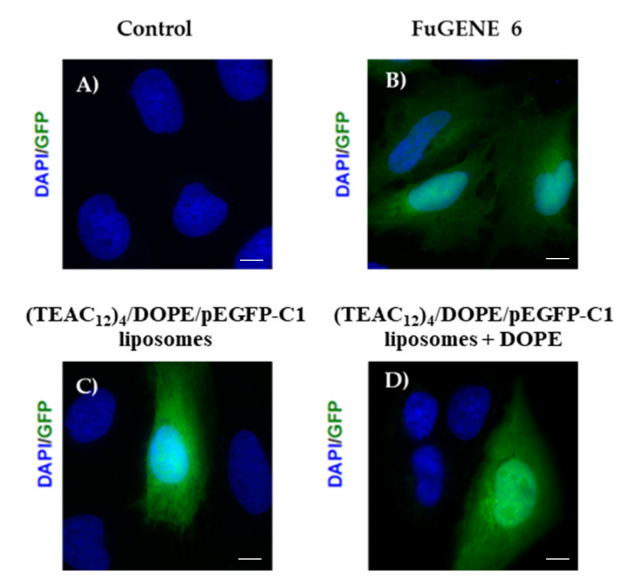
Figure 11. Representative images of GFP positive cells after transfection with 3 µ g of pEPFG-C1. ( A ) Control; ( B ) FuGENE 6; ( C ) (TEAC 12 ) 4 /DOPE/pEGFP-C1 lipoplexes at α = 0.3 and L/D = 90; ( D ) (TEAC 12 ) 4 /DOPE/pEGFP-C1 lipoplexes at α = 0.3 and L/D = 90 in the presence of additional DOPE. Scale bar: 10 µ